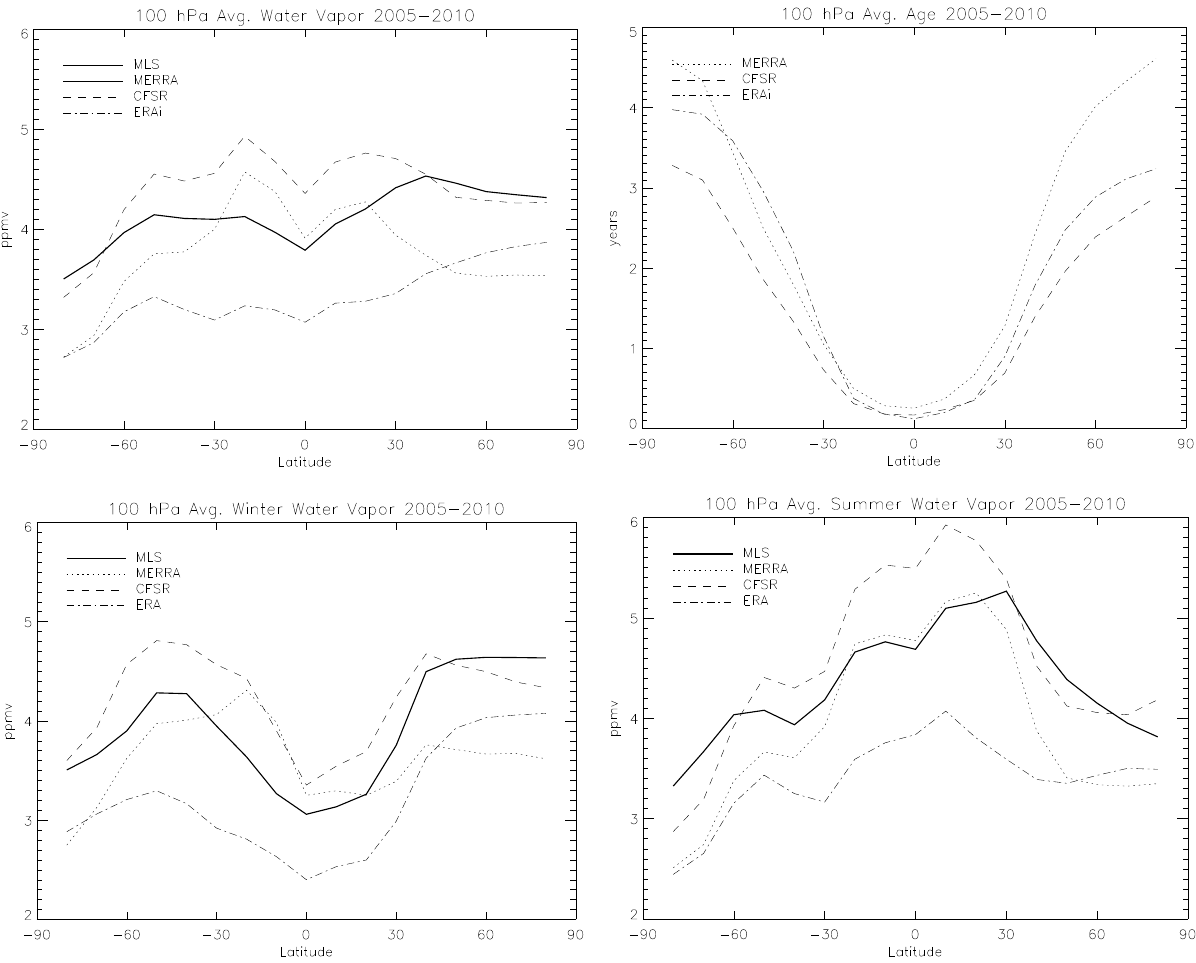
Fig. 5. Zonal (a) water vapor at 100hPa all seasons (b) mean age. Zonal mean water vapor boreal winter (c) boreal summer (d) , MLS, solid, MERRA, dotted, CFSR, dash, ERAi